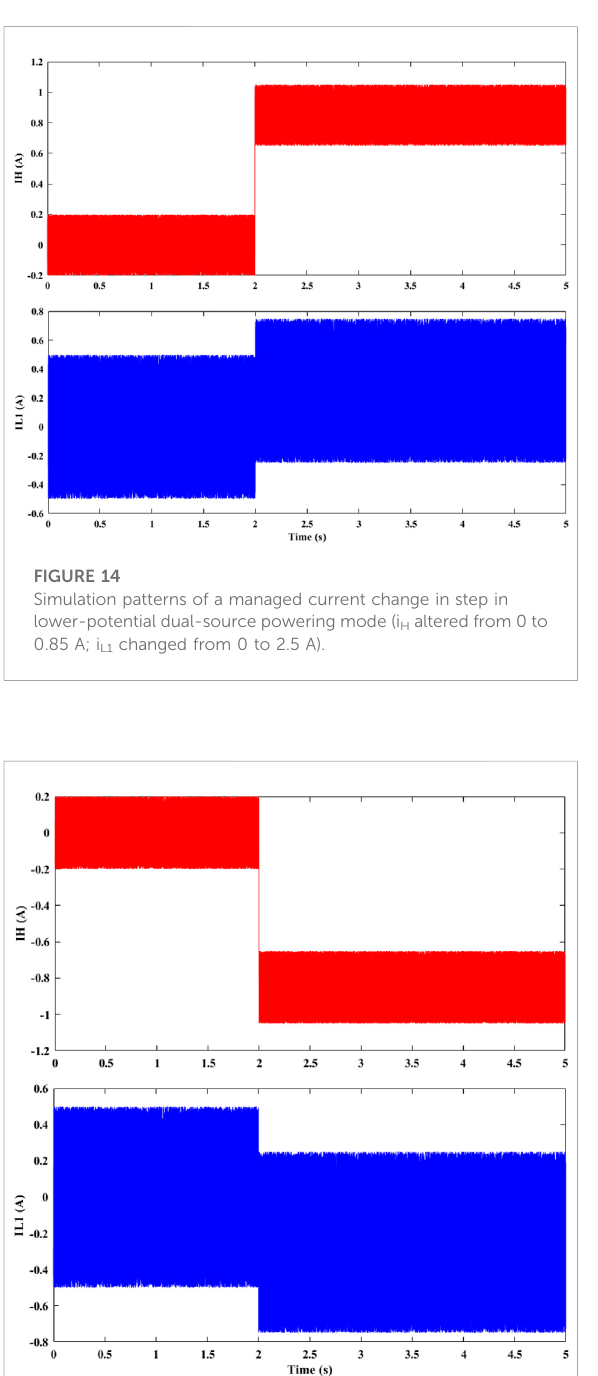
FIGURE 15 Simulation patterns of managed changes in current at step level in the higher-potential dc-bus power-regenerating mode (i H altered from 0 to − 0.85 A; i L1 changed from 0 to − 2.5 A).